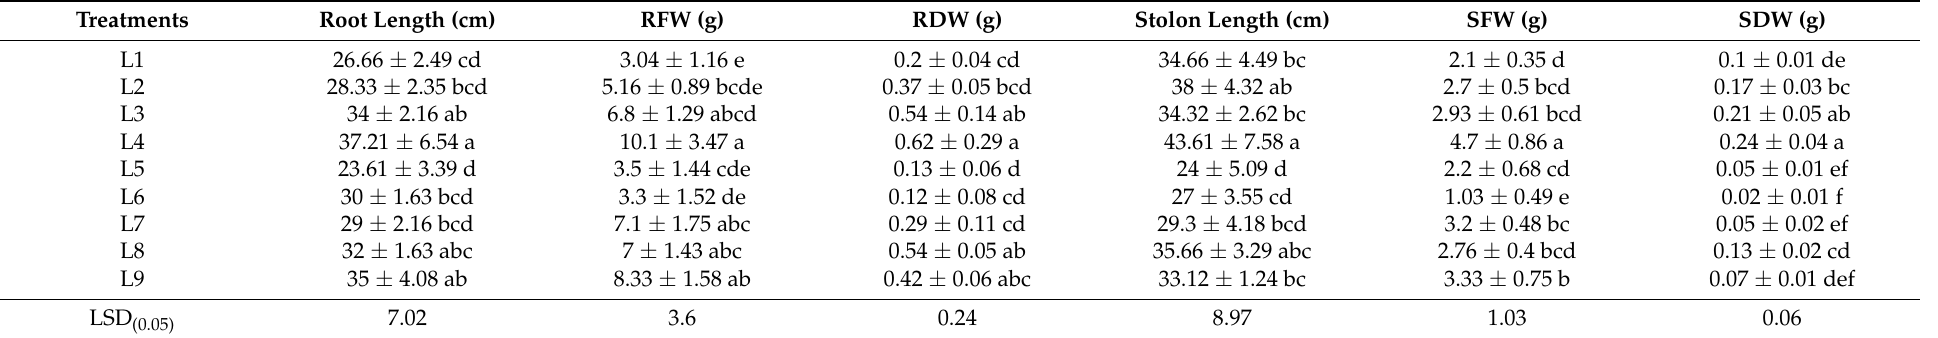
Table 4. Effect of LED lights on morphological traits of potato plants (root and stolon) in the aeroponic